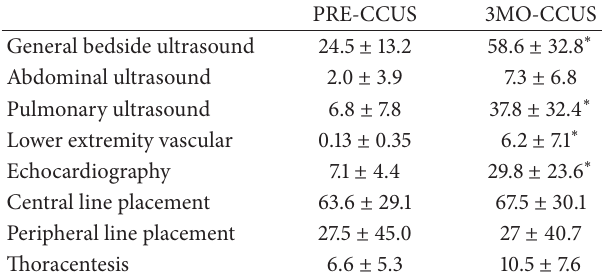
Table 4: Number of self-reported ultrasound examinations per- formed per ICU month at precourse and 3-month follow-up. Results reported as mean ± SD. “PRE-CCUS” group was surveyed within 1 week before CCUS course and “3MO-CCUS” group was surveyed 3 months after CCUS course. ∗ 𝑝 < 0.05 when compared to PRE- CCUS